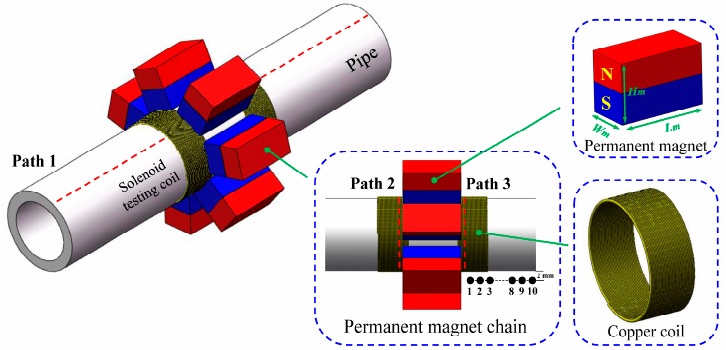
Figure 3. The simulation model of the proposed EMAT.